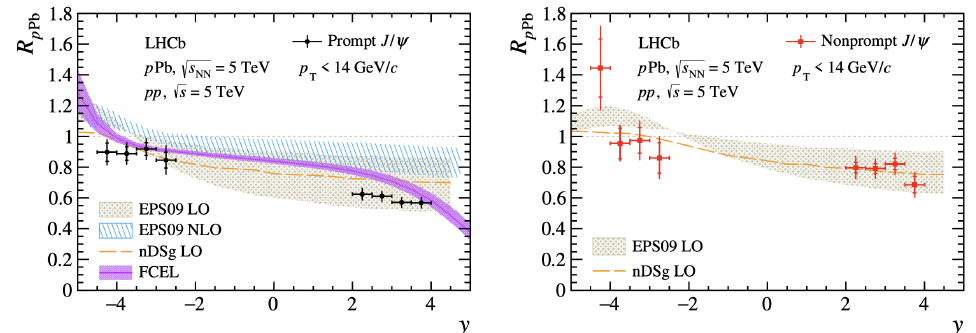
Figure 19. The prompt J / ψ nuclear modification ( left ) is shown with the nonprompt J / ψ nuclear modification ( right ) as a function of rapidity in p + Pb collisions [85]. The data are compared with different theoretical models described in the text. Reprinted with permission from Springer Nature.